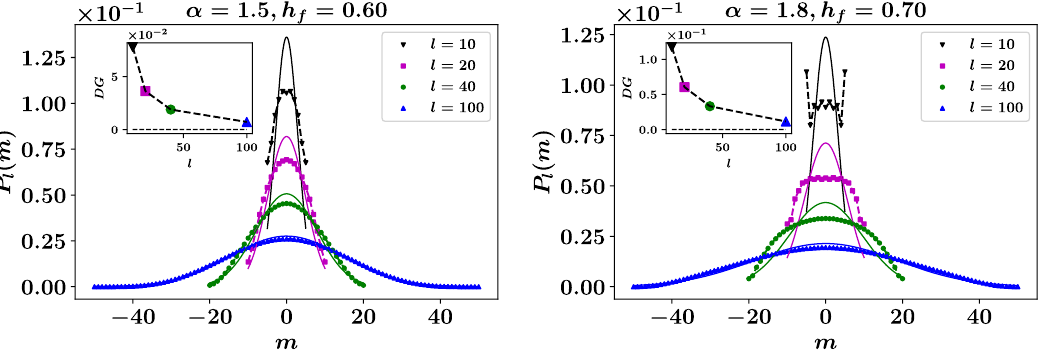
Figure 5: The PDF of subsystem magnetization after a quantum quench at time t = 25 for subsystem sizes l ∈ { 10,20,40,100 } for two representative values of post quench = 0.60, and α = 1.8, hf = 0.70. The symbols are the TDVP parameters α = 1.5, h f results whereas the corresponding full lines are the Gaussian approximation 10. In the inset we show the dependence of DG on the subsystem